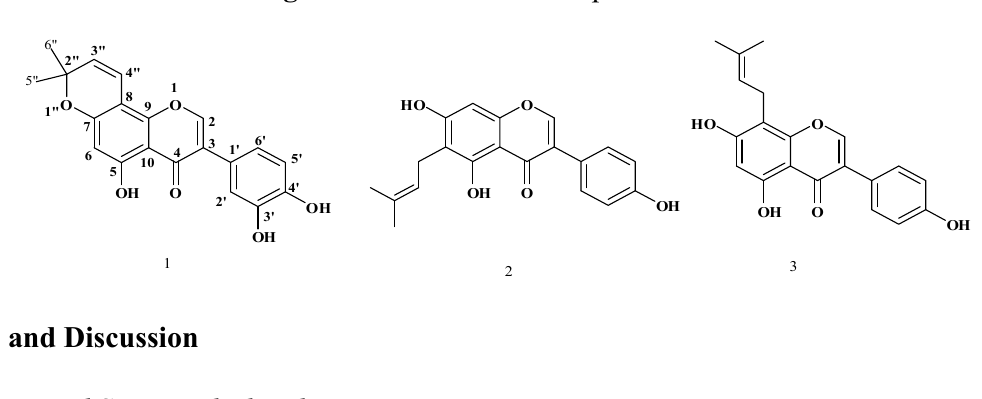
Figure 1. Structures of compounds 1 – 3